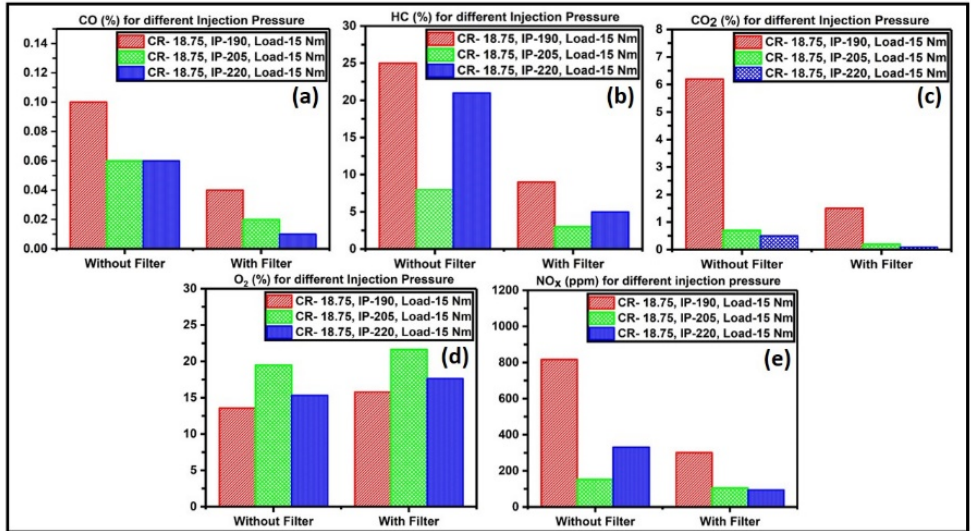
Figure 9. ( a ) CO emission, ( b ) HC emission, ( c ) CO 2 emission, ( d ) NO x emission, and ( e ) O 2 emission recorded when CR = 18.75; IP = 190, 205, and 220 bar; load = 10 Nm. Figure 10a–e present the emissions of the third test cycle taken by varying the load to 10, 15, and 20 Nm, whereas the CR and IP are at 18.75 and 205 bar, respectively. For part